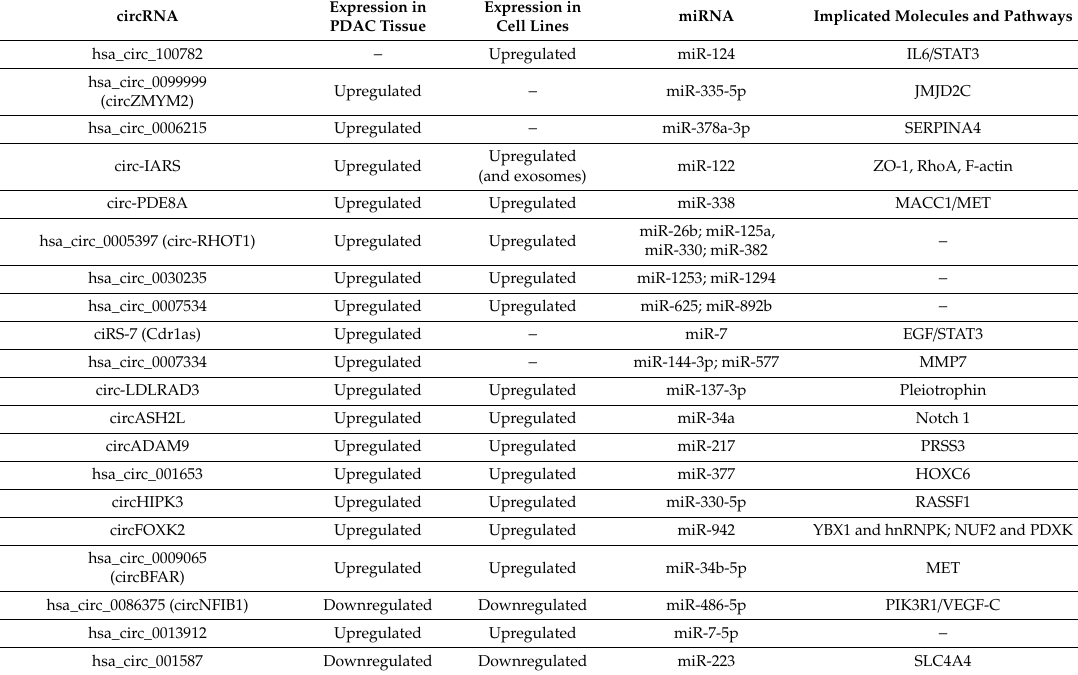
Table 2. Summary of investigated circRNAs in PDAC with proposed ceRNA